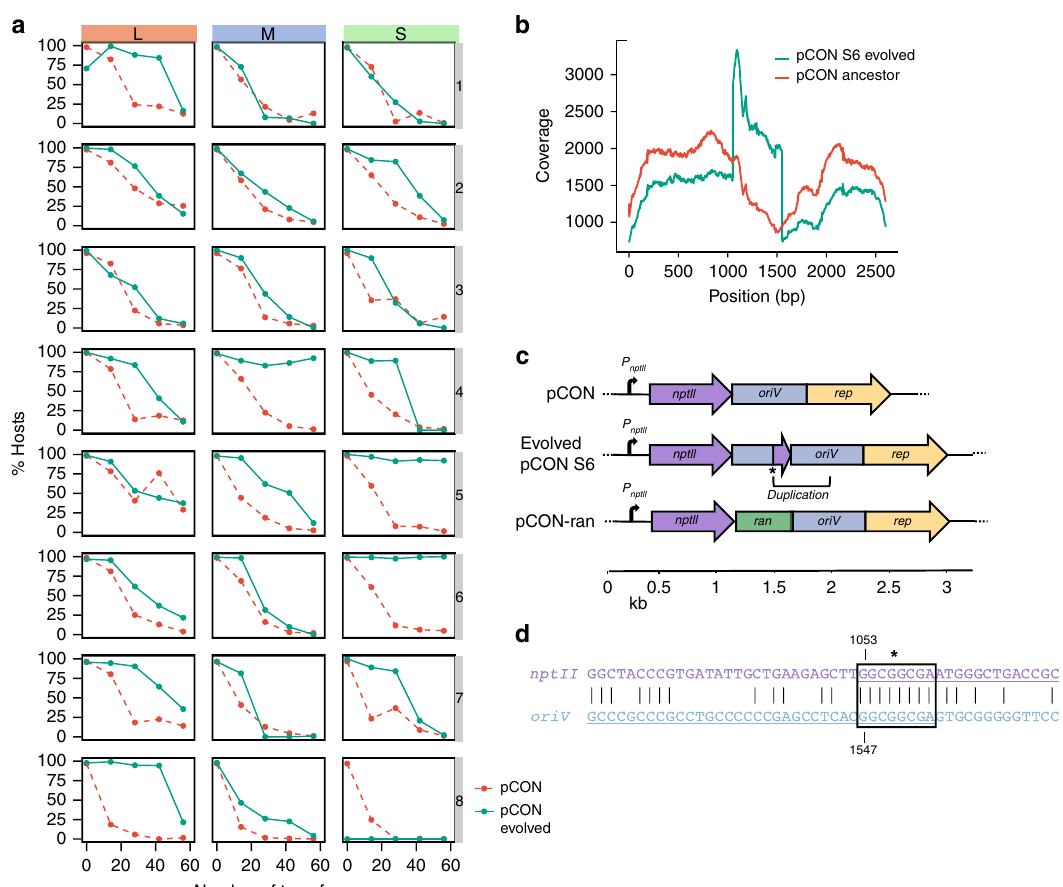
Fig. 2 Follow-up evolution experiment of evolved pCON hosts at 37 °C. a Plasmid persistence under non-selective conditions after selection for evolved plasmid-carrying populations (green) compared against pCON persistence during the fi rst experiment (Fig. 1a) at 37 °C (red, dashed lines). The experiment was conducted for 56 transfers corresponding to about 340 generations in L populations, 450 generations in M populations, and 560 generations in S populations. b Sequencing coverage distribution of ancestral and evolved pCON variants from population S6. The presented coverage was divided by the mean coverage. c Genomic map of pCON plasmids. The pCON variant S6 encountered a segmental duplication downstream the nptII gene including 125 bp of nptII and 372 bp of the oriV . The fusion site is indicated by a star symbol. In pCON-ran a random DNA segment of 500 bp was placed between nptII and the oriV . d Nucleotide sequence of the fusion site of nptII and the oriV . The black box indicates a microhomology region (8 bp) within which the illegitimate fusion potentially occurred. Extended homologies are shown up and downstream of the fusion site. Source data are provided as